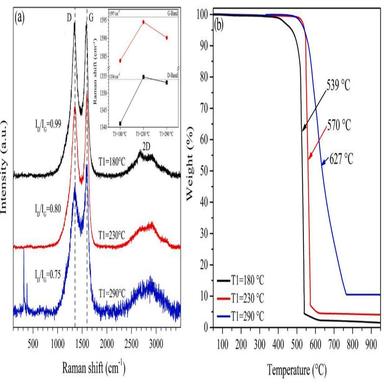
Cristina L. Rodríguez-Corvera et al. (a) Raman spectra and (b) TGA curves for samples synthesized at T1 = 180 ◦C, 230 ◦C, and 290 ◦C. In (a), the dotted vertical lines refer to D- and G-band peaks for graphite, the values of ID/IG ratio are indicated. Also, Raman peaks at 313.2 cm− 1 and 378.89 cm− 1 are related to the pyrrhotite structure. A close-up image showing these peaks; see Fig. S6. A large downshift for the D-band (1340 cm− 1 ), and G-band (1583 cm− 1 ) for the T1 = 180 ◦C sample was observed (see